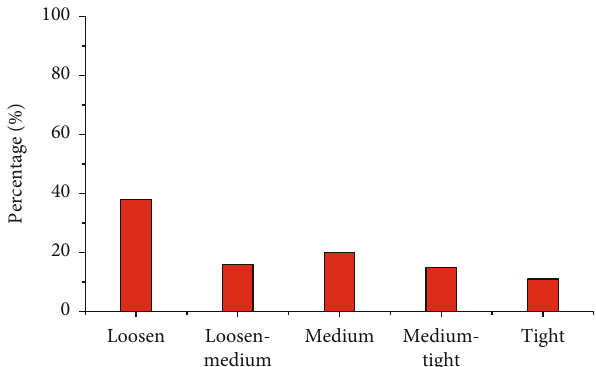
Figure 3: Histogram of frequency distribution of tightness degree of reservoir debris in block Yingmai